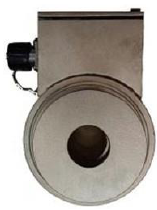
Figure 15. YAD400 mine bolt cable dynamometer. The arrangement of monitoring points is shown in Figure 16.